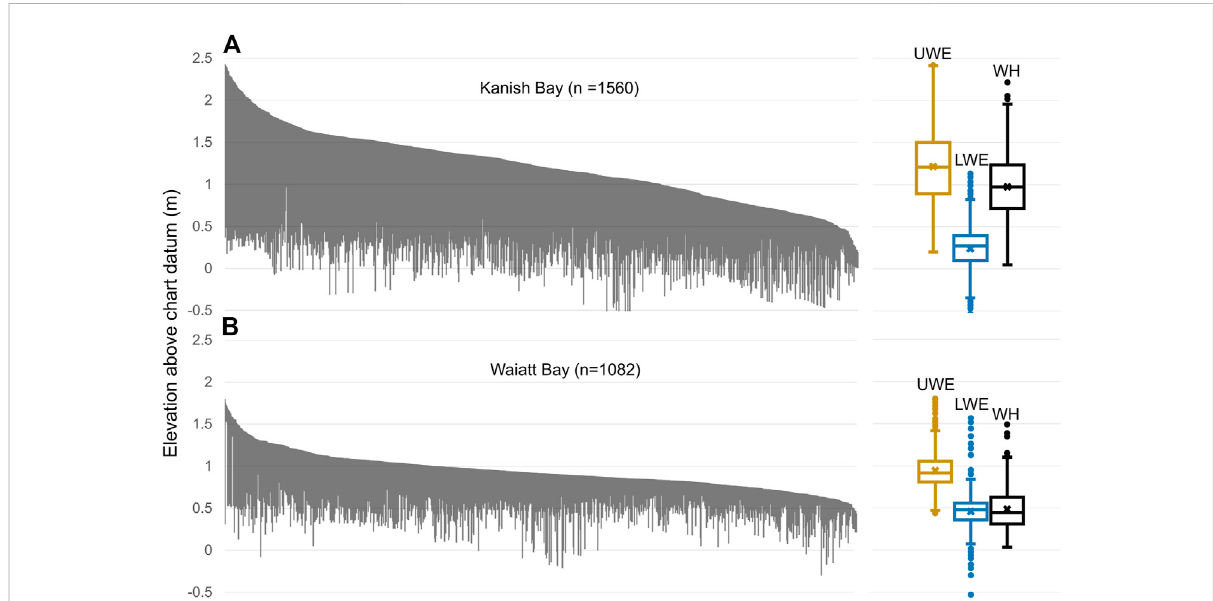
FIGURE 5 Kanish Bay (A) , n = 1,560 and Waiatt Bay (B) , n = 1,082 wall elevation samples arranged from highest upper wall elevation to lowest above Canadian chart datum (Lower LowWater Large Tide; LLWLT). Each vertical grey line represents an upperand lower elevation of a5-m length ofwall. For the boxplot summaries, UWE = Upper wall elevation, LWE = Lower wall elevation, WH = Wall height. Note the higher median elevations and wall heightsinKanishBayrelativetoWaiattBay.Thus,whilewecancomparedifferencesintheoverallshapeoftheplots,wecannotmakeinferences about change through time between the two